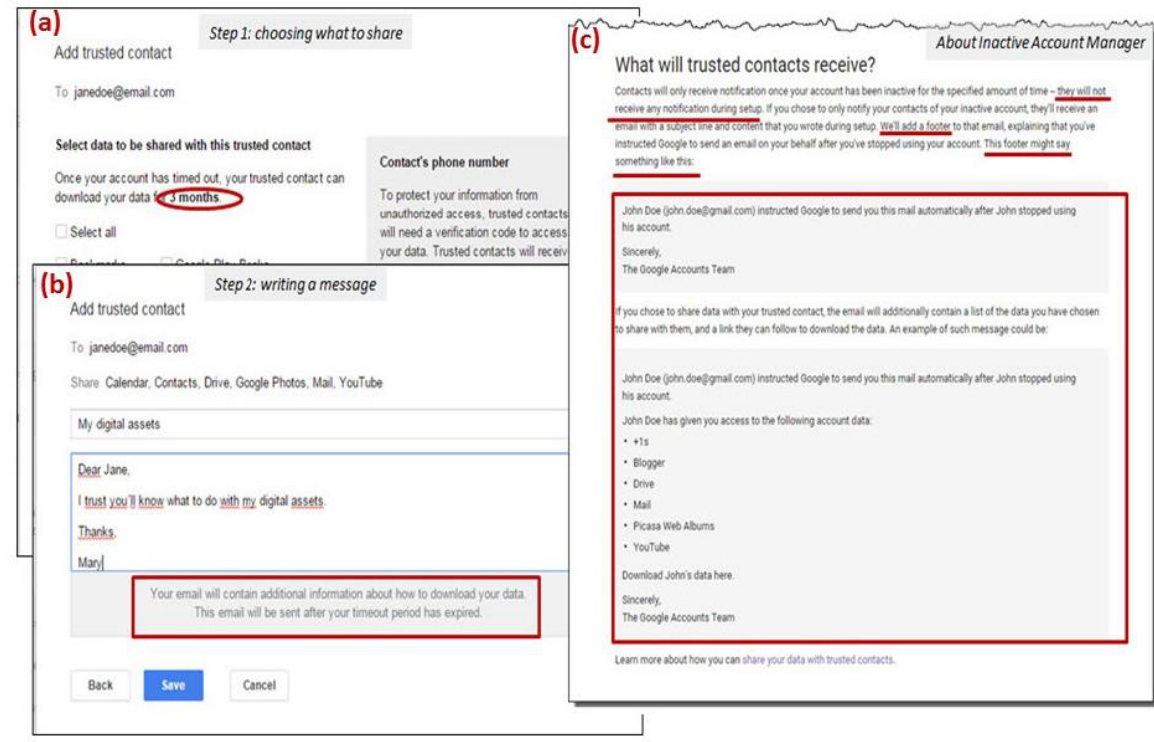
Fig. 5. Information effects scattered in (a) Dialog in which users choose what to share with trusted contact; (b) Dialog in which users write a message to trusted contact; (c) help page about inactive account